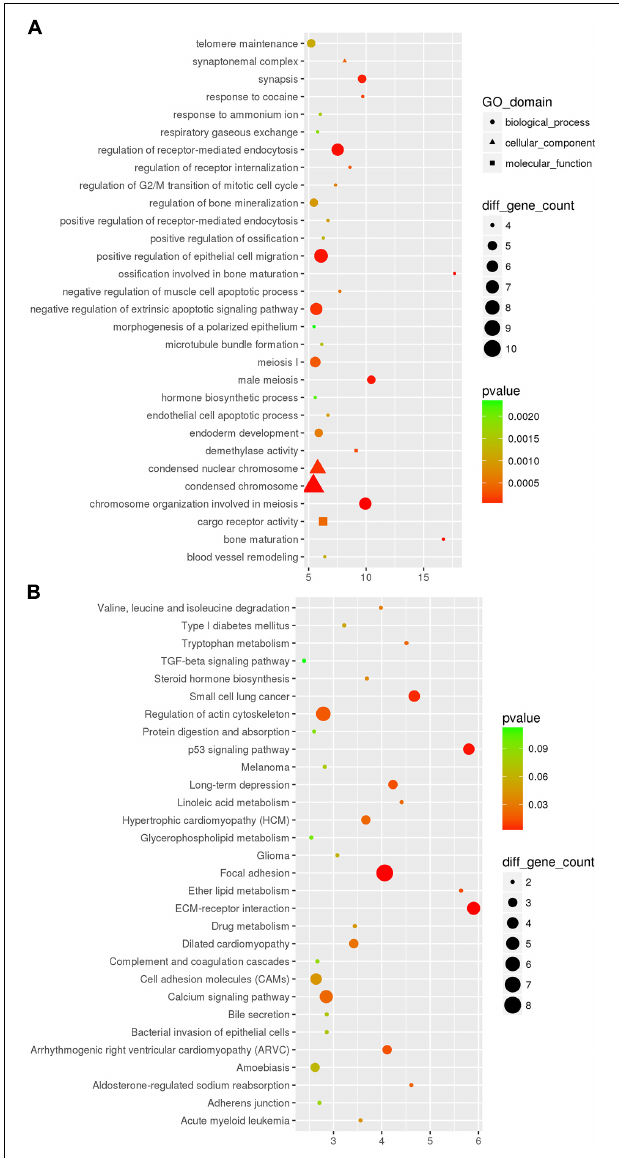
FIGURE 6 | The top 30 most significantly enriched GO (A) and KEGG (B) pathways of DEceRNAs of miRNAs sponged by DEcircRNAs between the Nrf2 (–/–) and Nrf2 (+/+) hippocampus. The x-axis shows counts of genes enriched in GO (A) and KEGG (B) pathways and the y-axis shows the GO and KEGG pathways. The color scale depicts the p